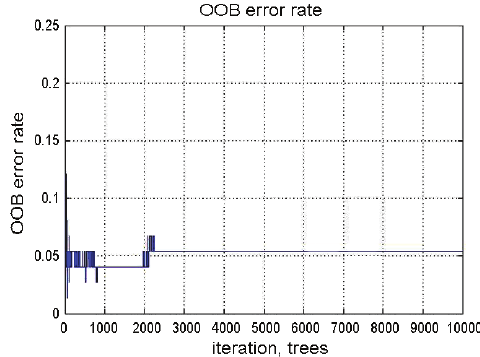
Fig. 2. RF application algorithm for PPP road infrastructure project modelling